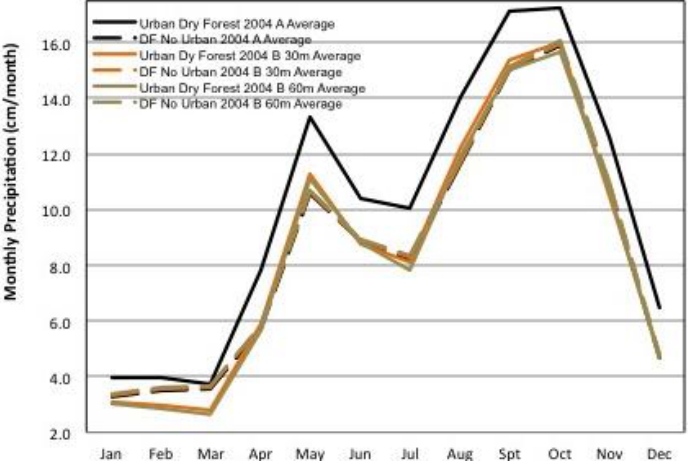
Figure 12. Average monthly precipitation for dry forest 2004 urban and non-urban.